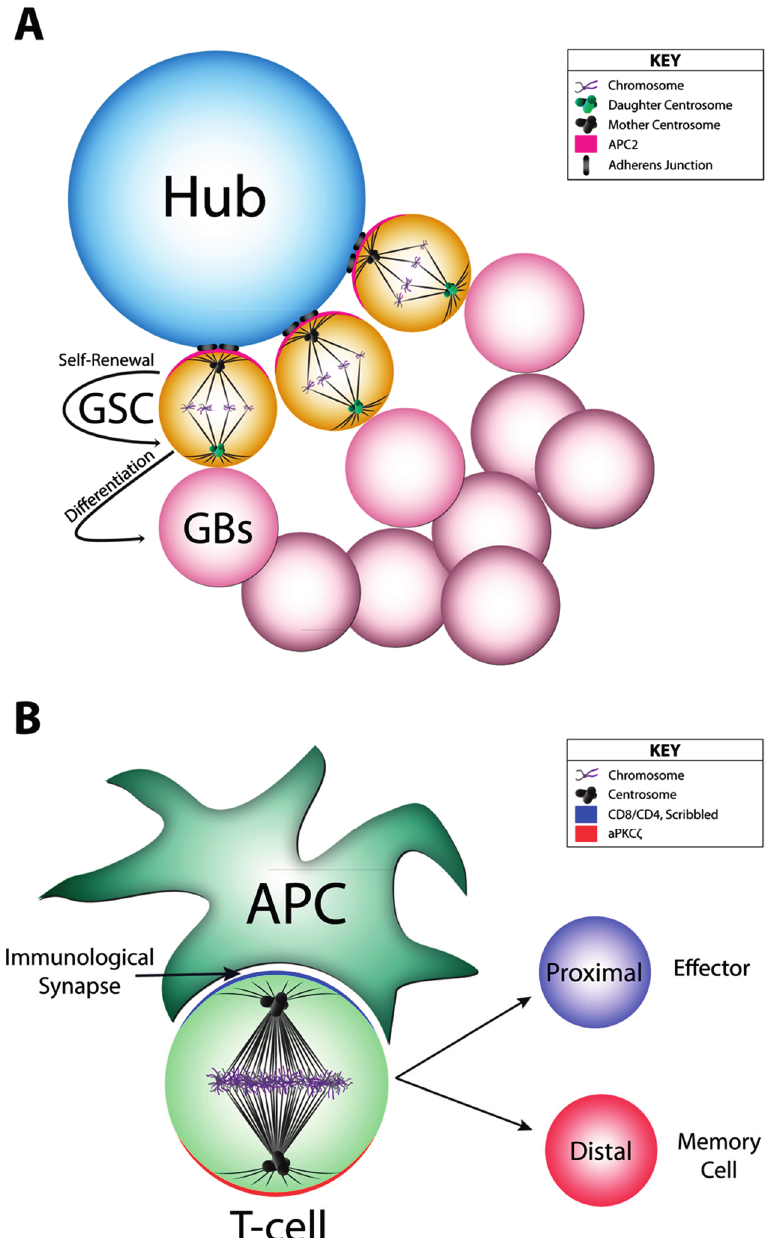
Figure 5. Spindle orientation to cell-adhesion cues. ( A ) Drosophila male germ line stem cells (mGSCs) form adherens junctions with a central hub cell and orient their mitotic spindles relative to this junction through the activity of the APC2 protein. Following division, the hub-proximal cell retains a stem cell fate, whereas the hub-distal cell becomes a gonial blast (GB) that differentiates further during spermatogenesis. Additionally, the GSC inherits the mother centrosome, while the daughter centrosome is segregated into the GB; ( B ) T-cell maturation initiates upon interaction with an APC at a specialized cell junction called the immunological synapse, mediated though interactions with CD8/CD4 receptors on the T-cell surface. APC interaction induces cell polarity in the T-cell, with Scribble (Scrib) localizing along the synapse and aPKC along the opposite cortical surface. Spindle orientation relative to the synapse generates a proximal and distal cell that differentiate into the Effector and Memory cell,